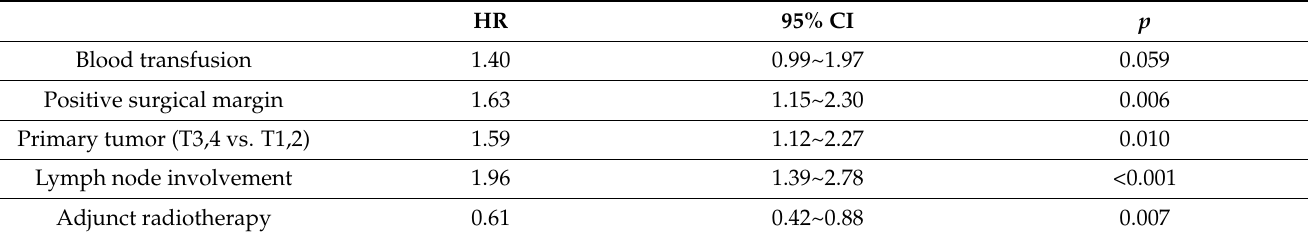
Table 3. Stepwise model selection for recurrence-free survival before IPTW. HR 95% CI p